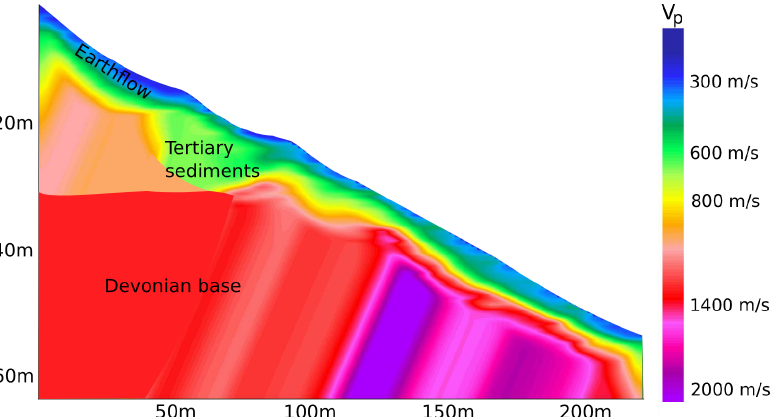
Figure 3. Tomogram of p-wave velocity derived for seismic profile 1 (see Figure 2a) and its subsequent